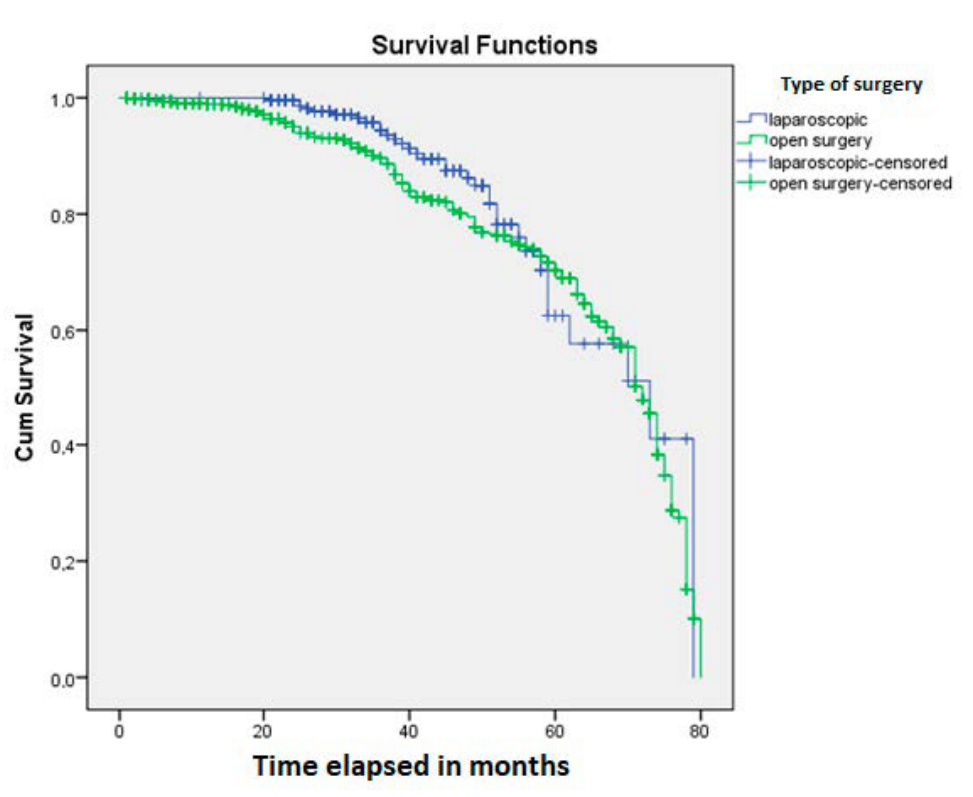
Figure 1. Patients with rectal cancer who underwent laparoscopic surgery did not show a longer overall survival than those who were treated by open surgery ( p = 0.44).